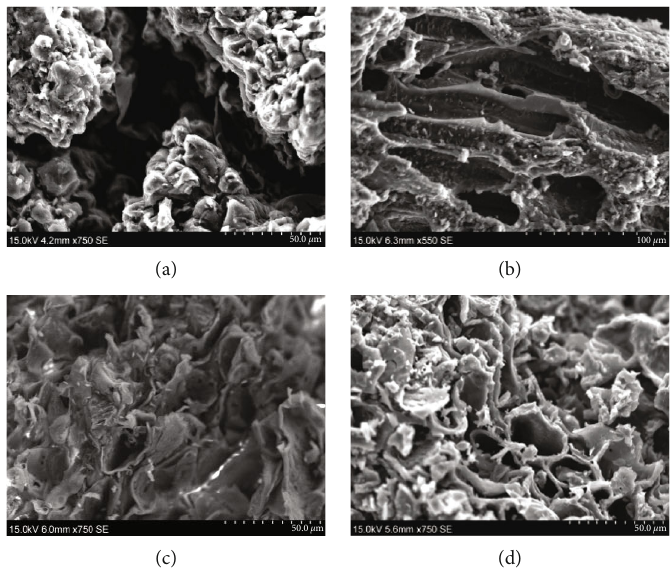
Figure 1: Scanning electron micrographs of TAADFPs activated at (a) 450 ° C, (b) 500 ° C, (c) 550 ° C, and (d) 600 °